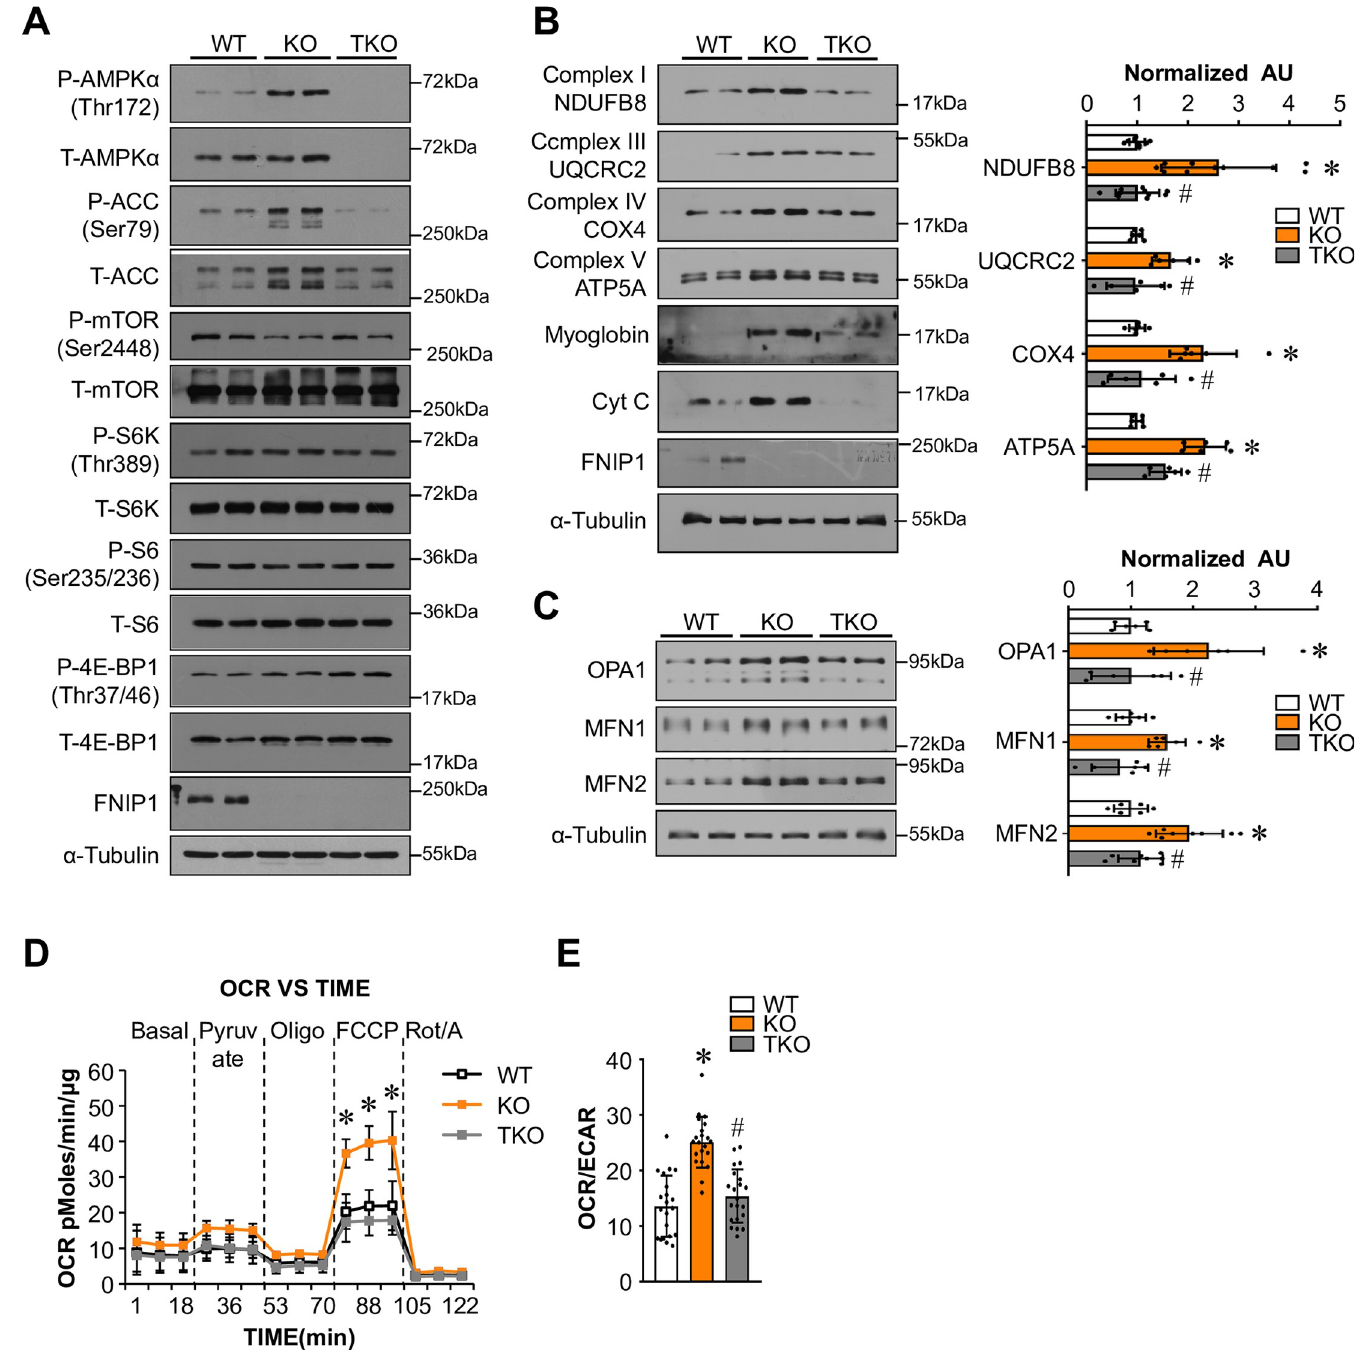
Fig 5. FNIP1 regulates muscle mitochondrial oxidative programs through AMPK in a cell-autonomous manner. ( A-C ) Primary myoblasts were isolated from GC muscles of indicated mice, and then induced to differentiation for 3 days. ( A ) Representative immunoblot analysis of myotube extracts using the indicated antibodies. n = 3–4 independent experiments. ( B , C ) Immunoblot analysis of myotube extracts using the indicated antibodies. Averaged NDUFB8/Tubulin, UQCRC2/Tubulin, COX4/Tubulin, ATP5A/Tubulin, OPA1/Tubulin, MFN1/Tubulin and MFN2/Tubulin ratios were shown after normalization to the value of WT controls. n = 3–5 independent experiments. ( D ) Oxygen consumption rates (OCR) in primary myotubes harvested from indicated mice. Basal OCR was first measured, followed by administration of 10 mM sodium pyruvate, and 2 μ M oligomycin (to inhibit ATP synthase), uncoupler FCCP (2 μ M), or rotenone/antimycin (Rot/A; 1 μ M) as indicted. n = 3 separate experiments done with 5–7 biological replicates. Data were analyzed by two-way ANOVA and Bonferroni post-hoc test. ( E ) OCR/ECAR ratio using pyruvate as substrate indicates a shift in cell energy production to oxidative phosphorylation. n = 3 separate experiments done with 5–7 biological replicates. Values represent mean ± SD, � P < 0.05 vs. WT controls, # P < 0.05 vs. Fnip1 KO